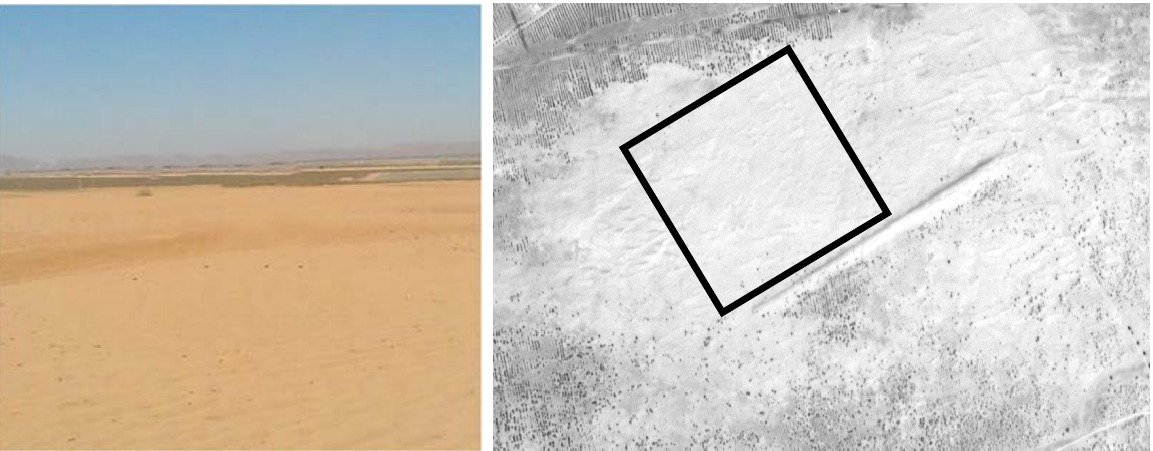
Figure 12. The desert area at Baotou calibration site.